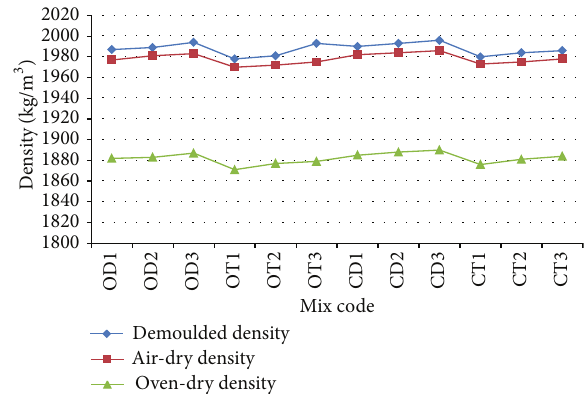
Figure 8: Variations of demoulded density, air-dry density, and oven-dry density for concrete mixes made from different species of OPS (original and crushed) and age